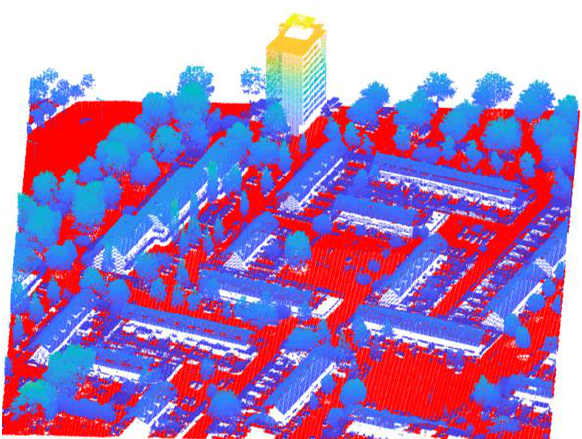
Figure 4. Ground classification using Model 1. Points predicted as ground are coloured in red